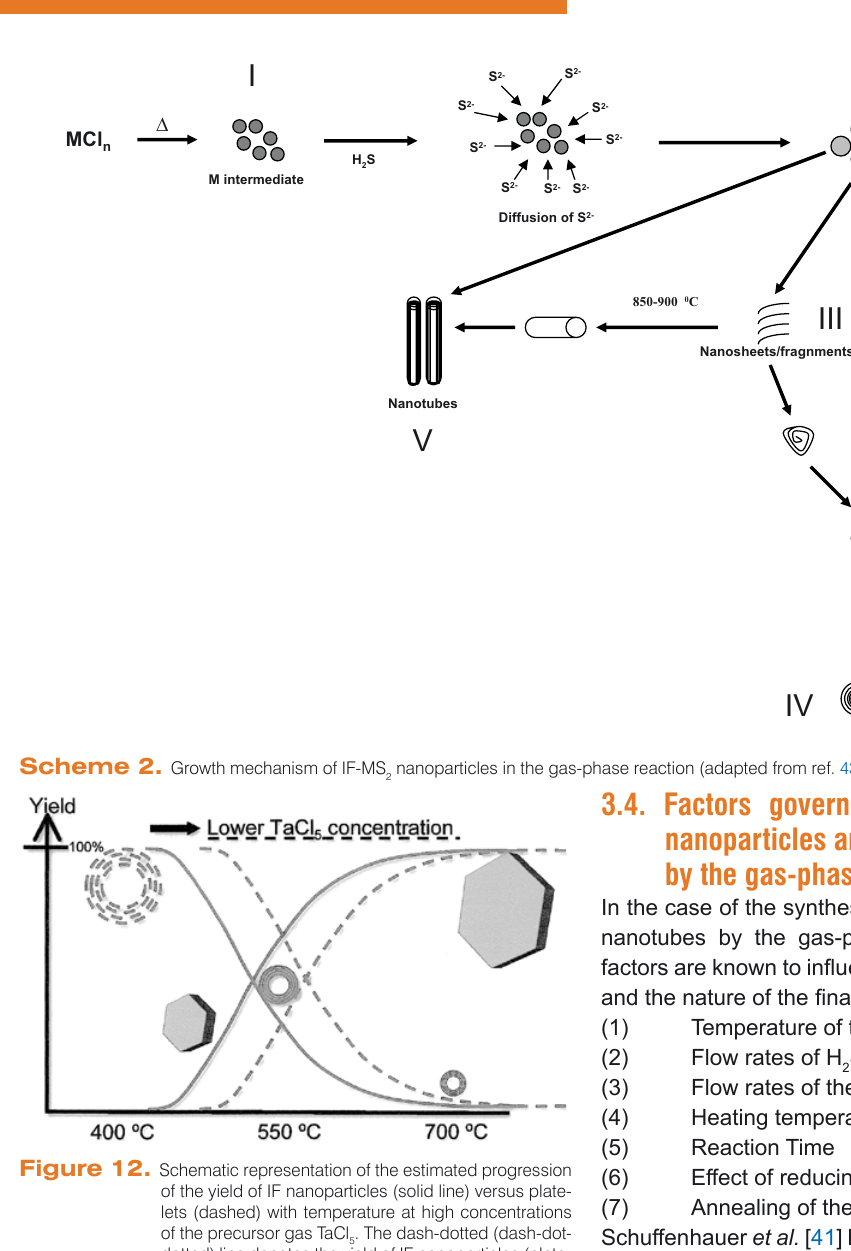
Figure 12. Schematic representation of the estimated progression of the yield of IF nanoparticles (solid line) versus plate- lets (dashed) with temperature at high concentrations of the precursor gas TaCl . The dash-dotted (dash-dot- 5 dotted) line denotes the yield of IF nanoparticles (plate- lets) at lower TaCl concentration. The particle size of 5 the platelets increases with temperature from ~ 100 nm diameter (400ºC) to ~ 200 nm diameter (700ºC). At higher temperatures, larger IF nanoparticles become unstable and are transformed into platelets (adapted from Ref.